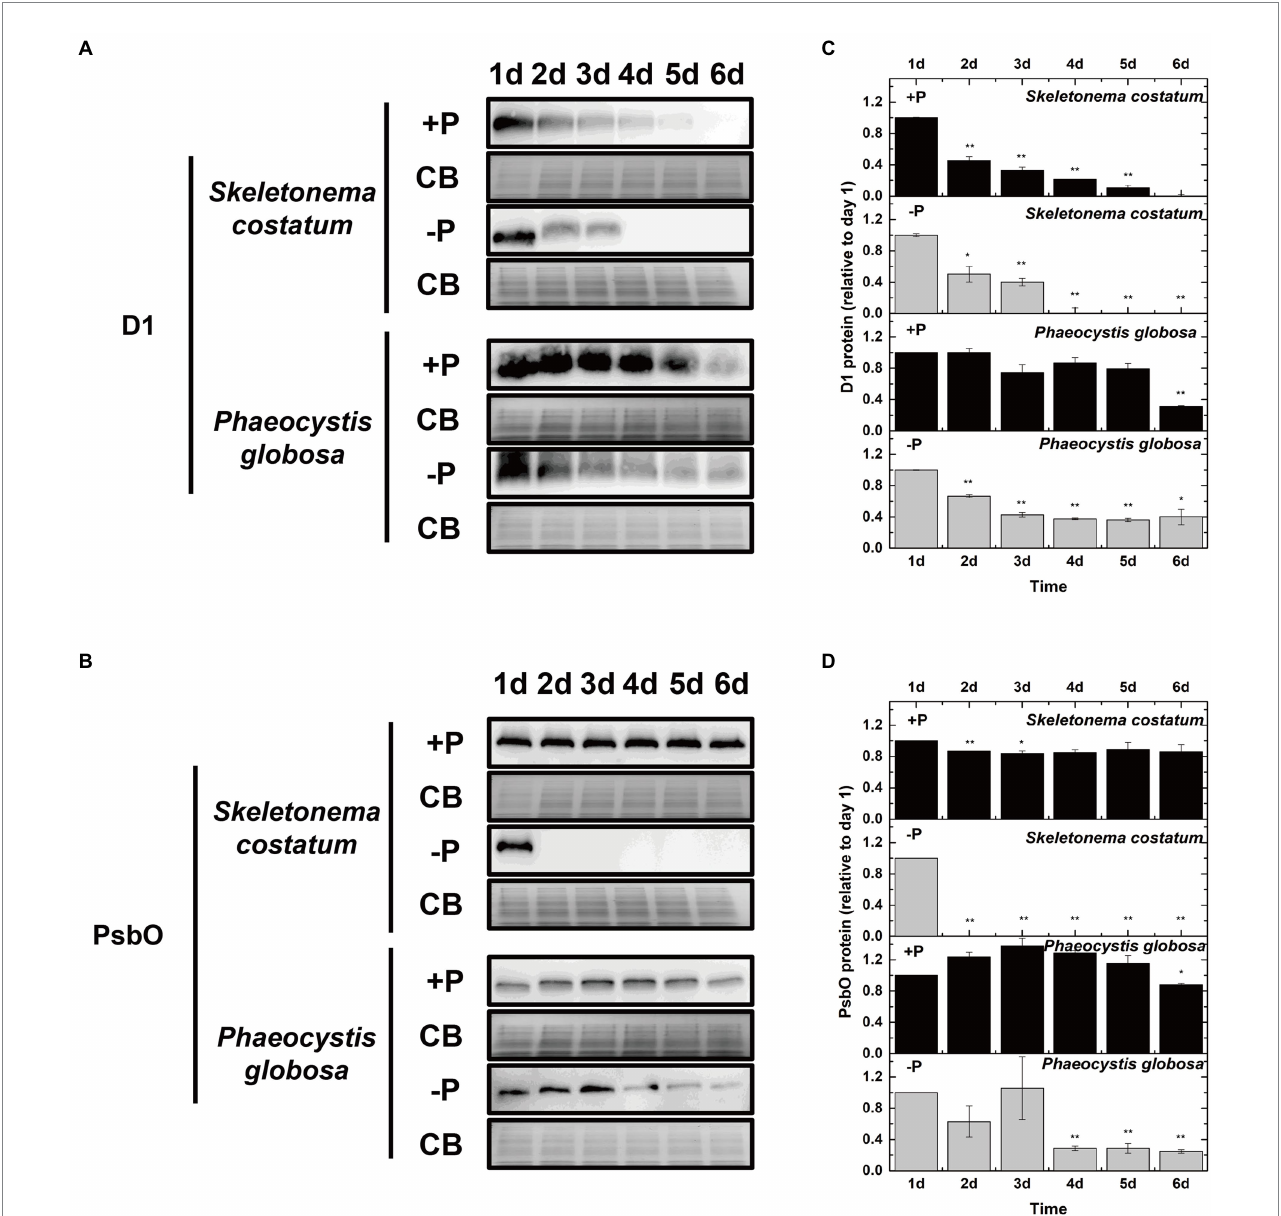
FIGURE 8 Immunoblot analysis of PSII proteins and stained with Coomassie blue (CB). (A) Immunoblot analysis was performed using antibodies specific to D1. (B) Immunoblot analysis was performed using an antibody specific to PsbO. (C) Ratios of the D1 protein level of P-limited cells were semi-quantitated by the immunoblot analysis relative to that of cells on day 1, which was set to 100% for easy comparison. (D) Ratios of the PsbO protein level of P-limited cells were semi-quantitated by the immunoblot analysis relative to that of cells on day 1, which was set to 100% for easy comparison. Error bars show mean ± standard error (SE) of triplicate treatments. Superscripts indicate significant differences between day 1 and other days according to a two-way ANOVA with a post-hoc test (** p < 0.01, * p <